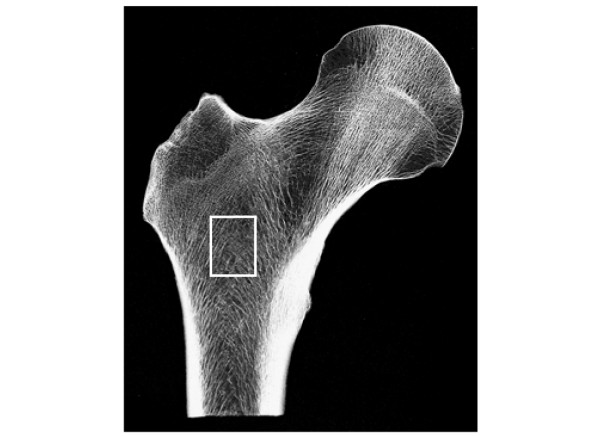
X-ray of a normal proximal femur, showing the intertrochanteric region (rectangle) used for sampling.